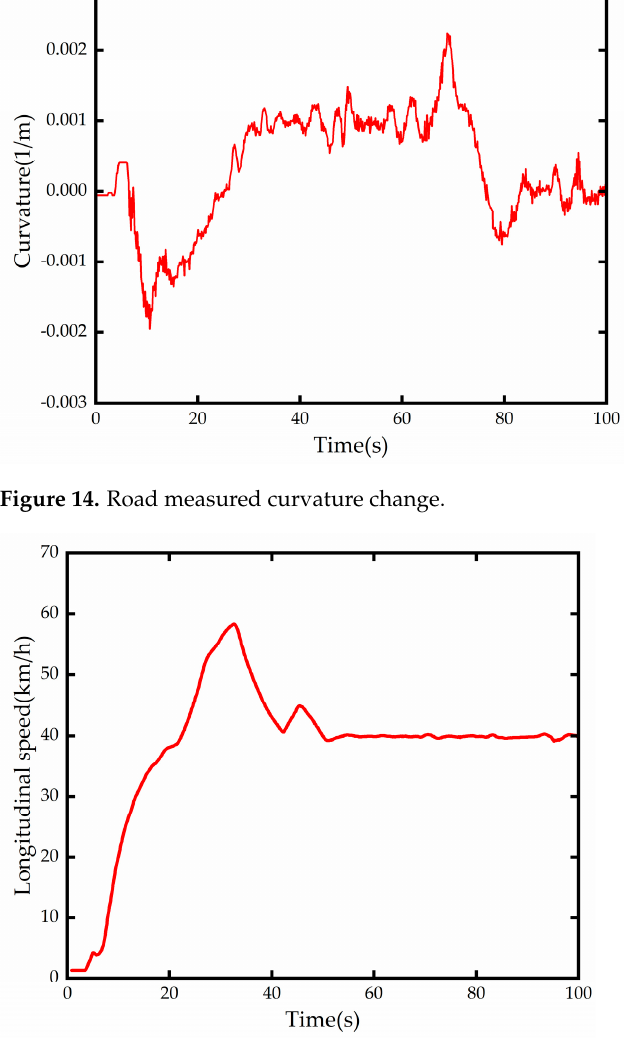
Figure 15. Longitudinal vehicle speed.